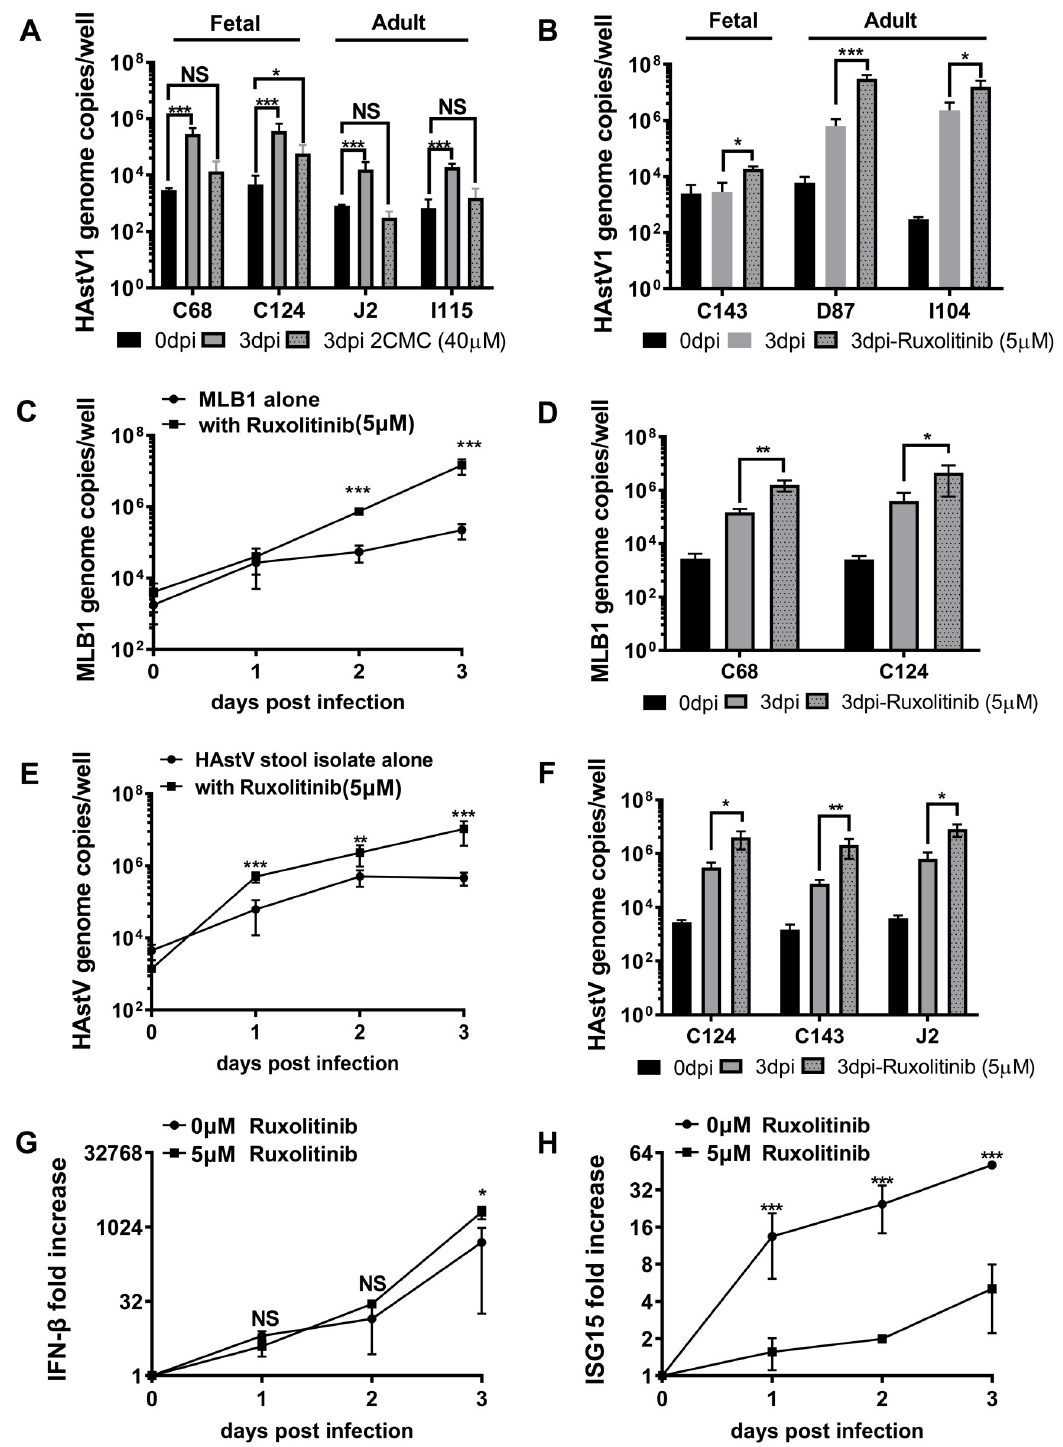
Fig 8. Pharmacological blockage of endogenous IFN response increases the infection of HIE by HAstV from all clades. A) HAstV1 (MOI = 1) infection of selected HIE derived from different human intestinal segments was carried out in the presence of trypsin and, when indicated, cells were further treated with 40 μ M 2’-C-methylcytidine (2CMC) after adsorption. Viral genome copies were determined at 0 and 3 dpi by RT-qPCR. B) HAstV1 (MOI = 1) infection of selected HIE derived from different human intestinal segments was carried out in the presence of trypsin and pre-treated for 12 hrs with or without ruxotinilib (5 μ M). Viral